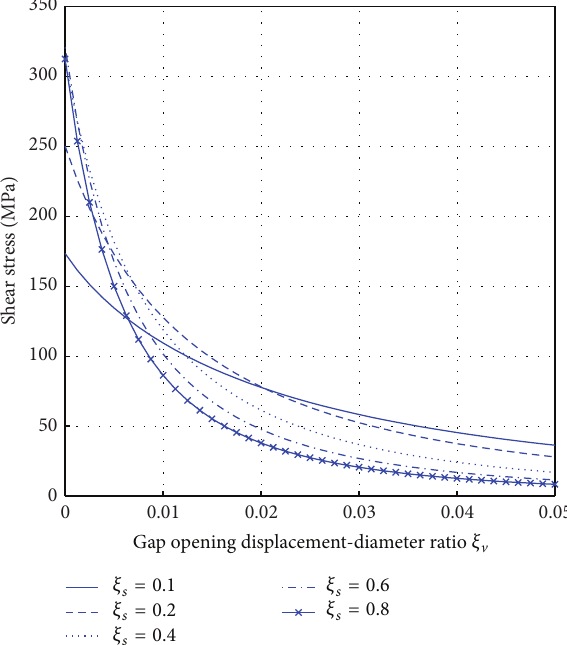
Figure 8: The curve of 𝜉 V to shear stress with different 𝜉 𝑠